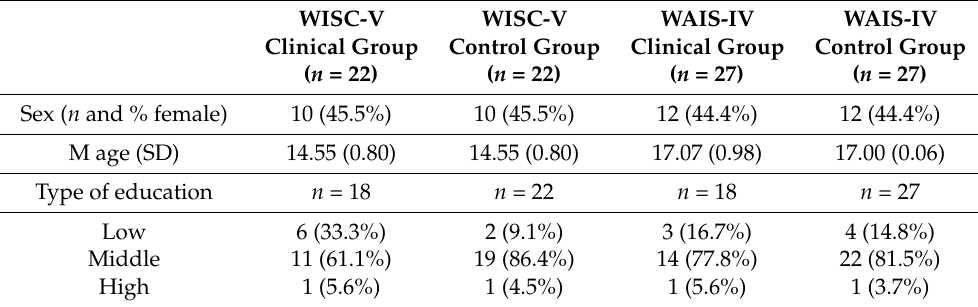
Table 1. Demographic description of the sample by